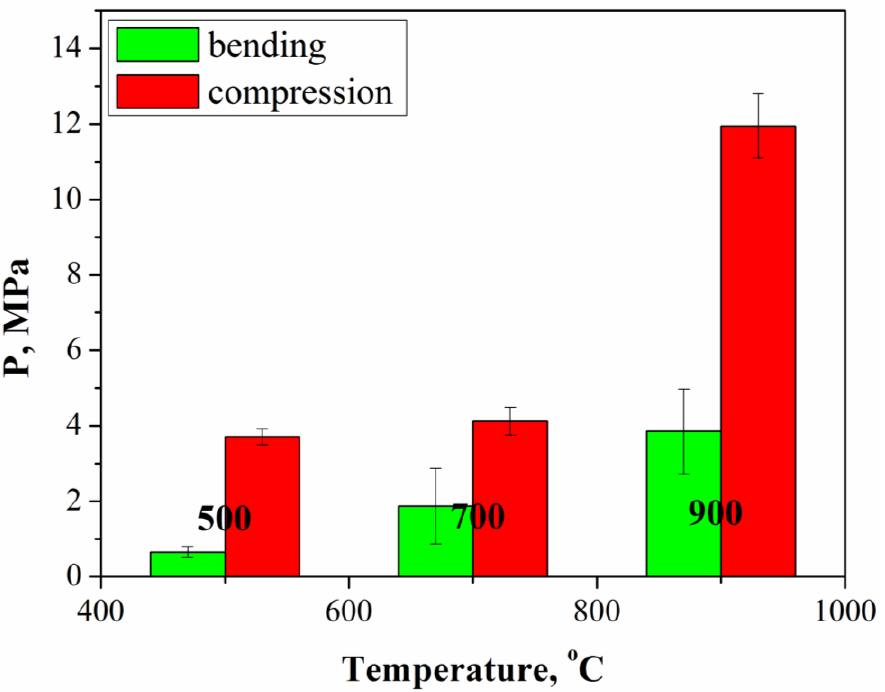
Figure 9. The compressive and bending strengths of the CaNa ceramic samples after annealing at temperature range of 500 – 900 °C.